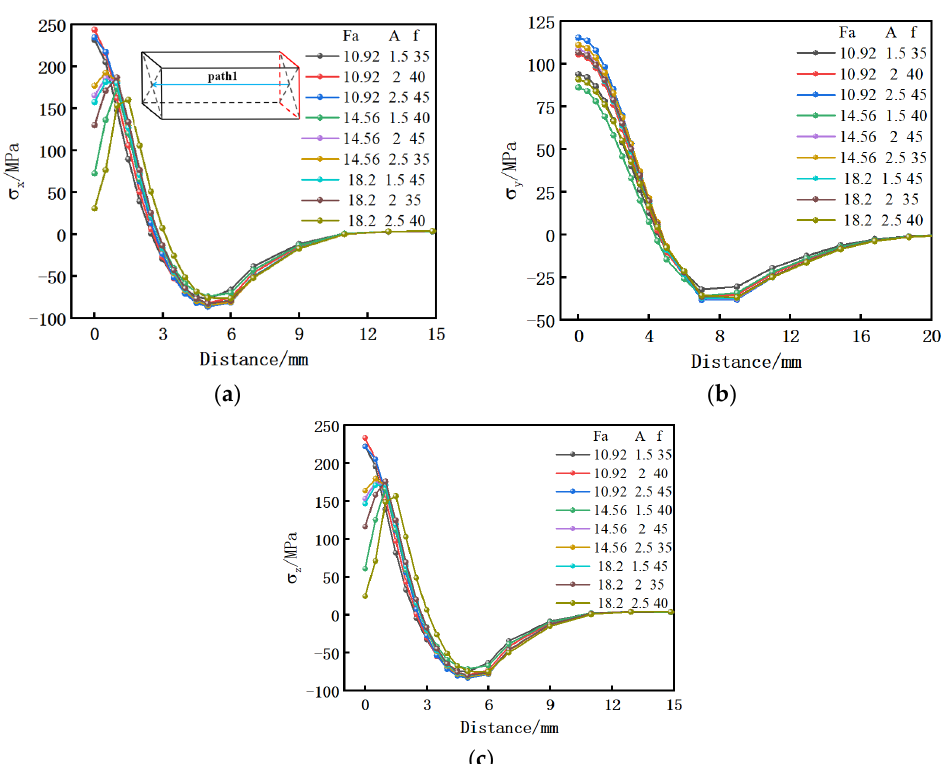
Figure 14. Stress distribution on path 1 of different welding parameters after cooling; ( a ) X direction; ( b ) Y direction; ( c ) Z direction. Table 1. Maximum residual stress with different welding parameters.